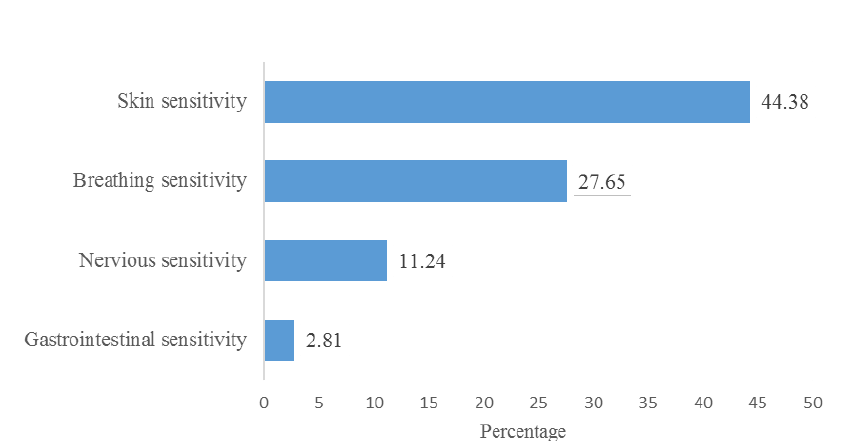
Figure 1. Percentage of common occurred sensitivity among hospital staff Fig 1. The percentage of common occurred sensitivity among hospital staffs